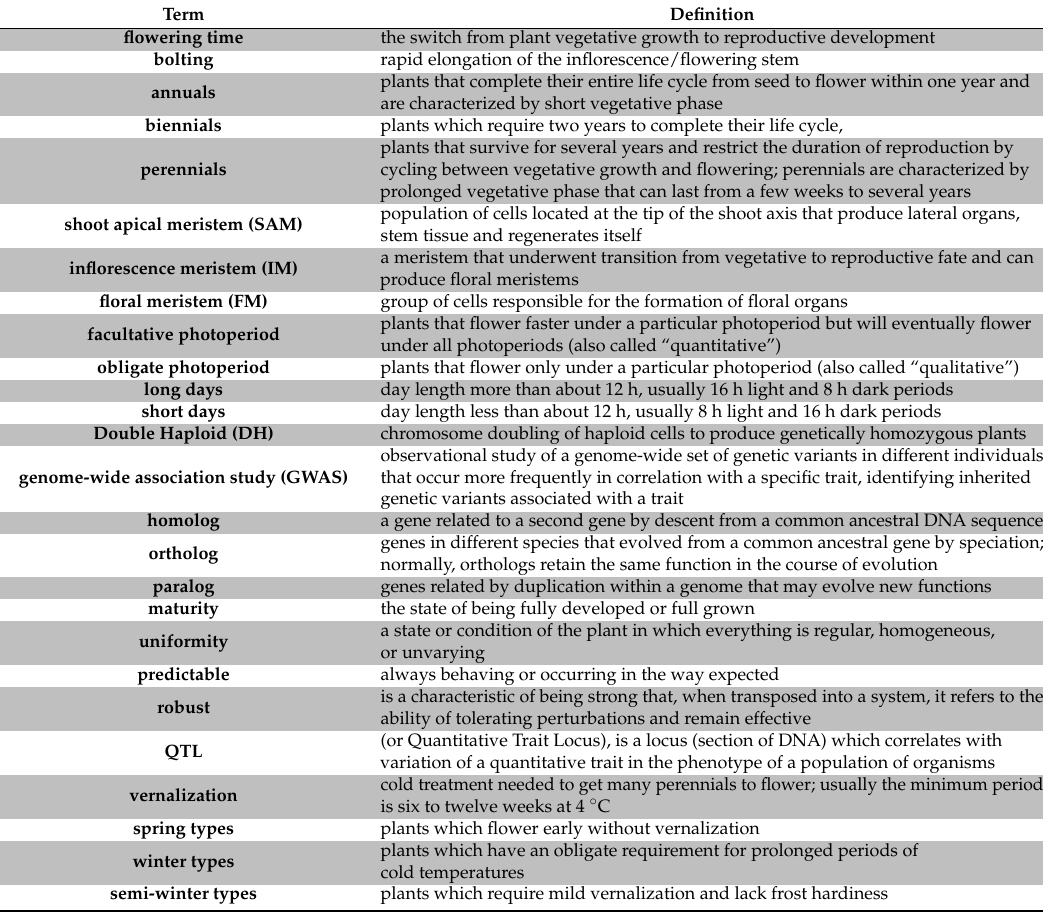
Table 1. Glossary of main terms as used in the